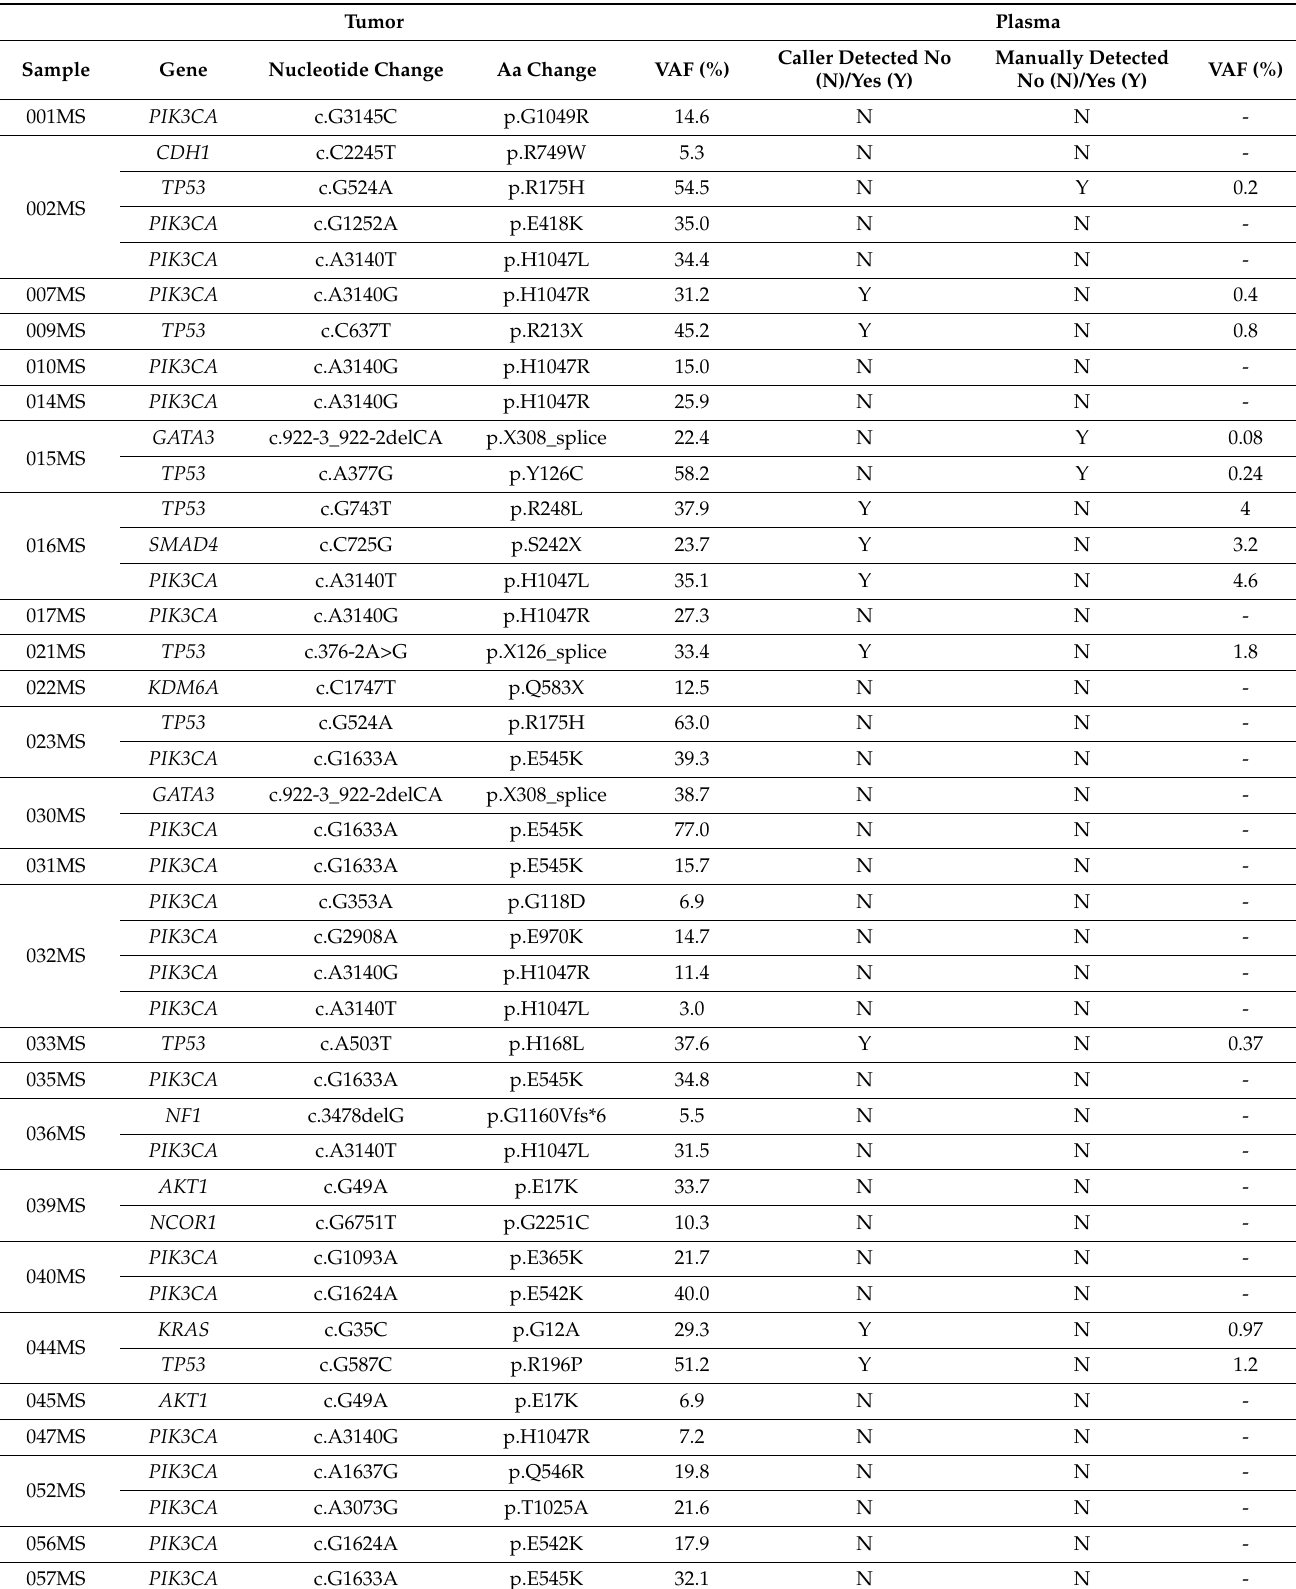
Table 2. Mutations detected in tumor and plasma